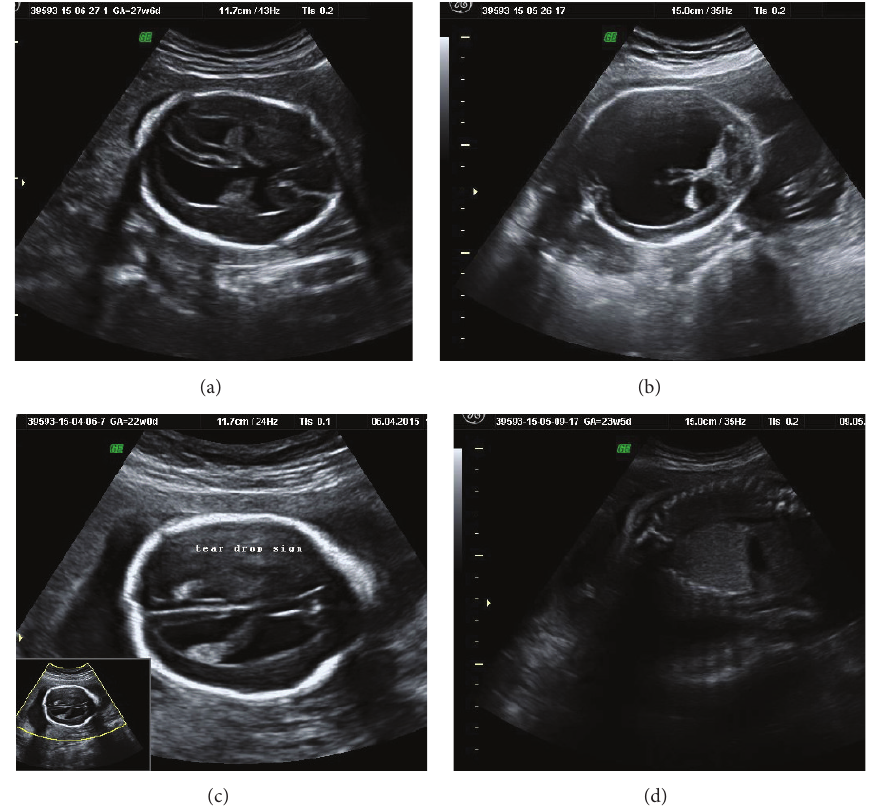
Figure 2: (a and b) show late onset hydrocephalus diagnosed at 27 weeks and 32 weeks, noted to occur late as a part of MASA syndrome (patient had history of X-linked hydrocephalus). (c) shows agenesis of corpus callosum which is known to be said with confirmation at later